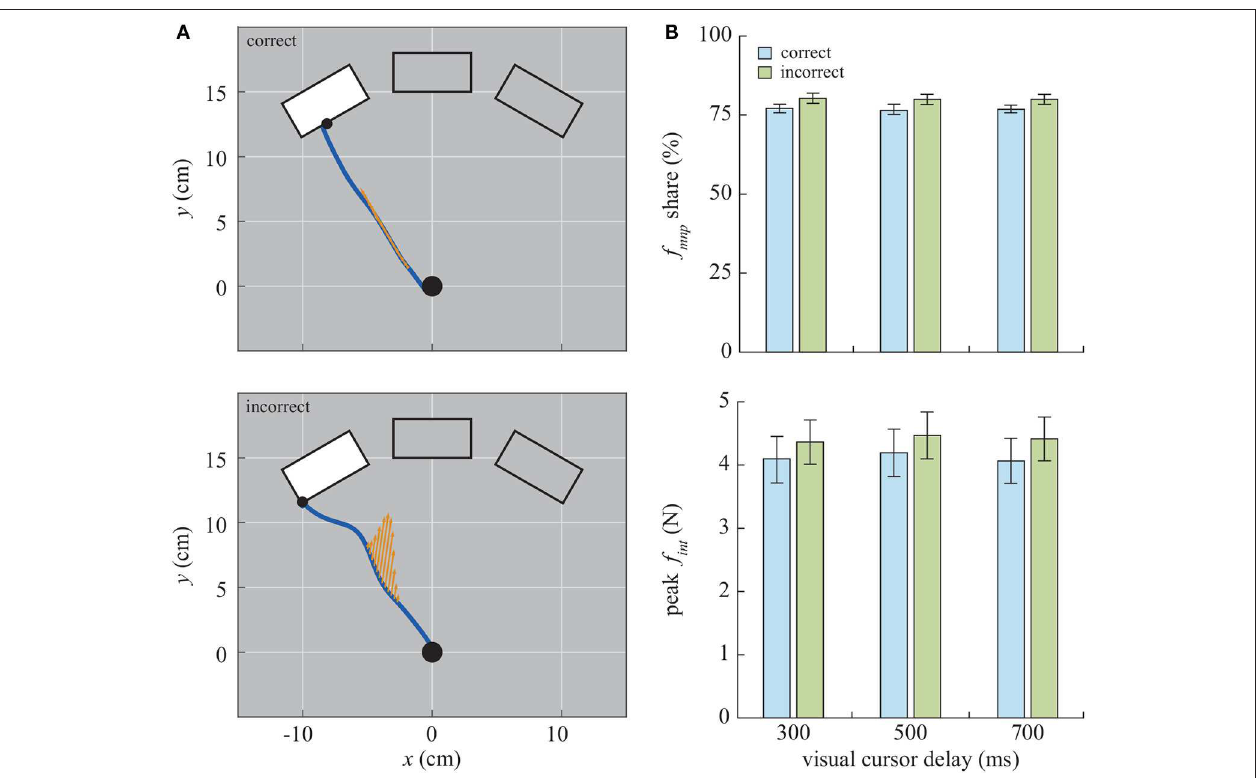
FIGURE 5 | (A) An illustration of the correct and incorrect force vectors from a single trial. The angle and the length of the arrows represent the magnitude and the direction of the guiding force, respectively. (B) The averaged manipulation share of the participants and the peak interaction force. The data from no-force condition is